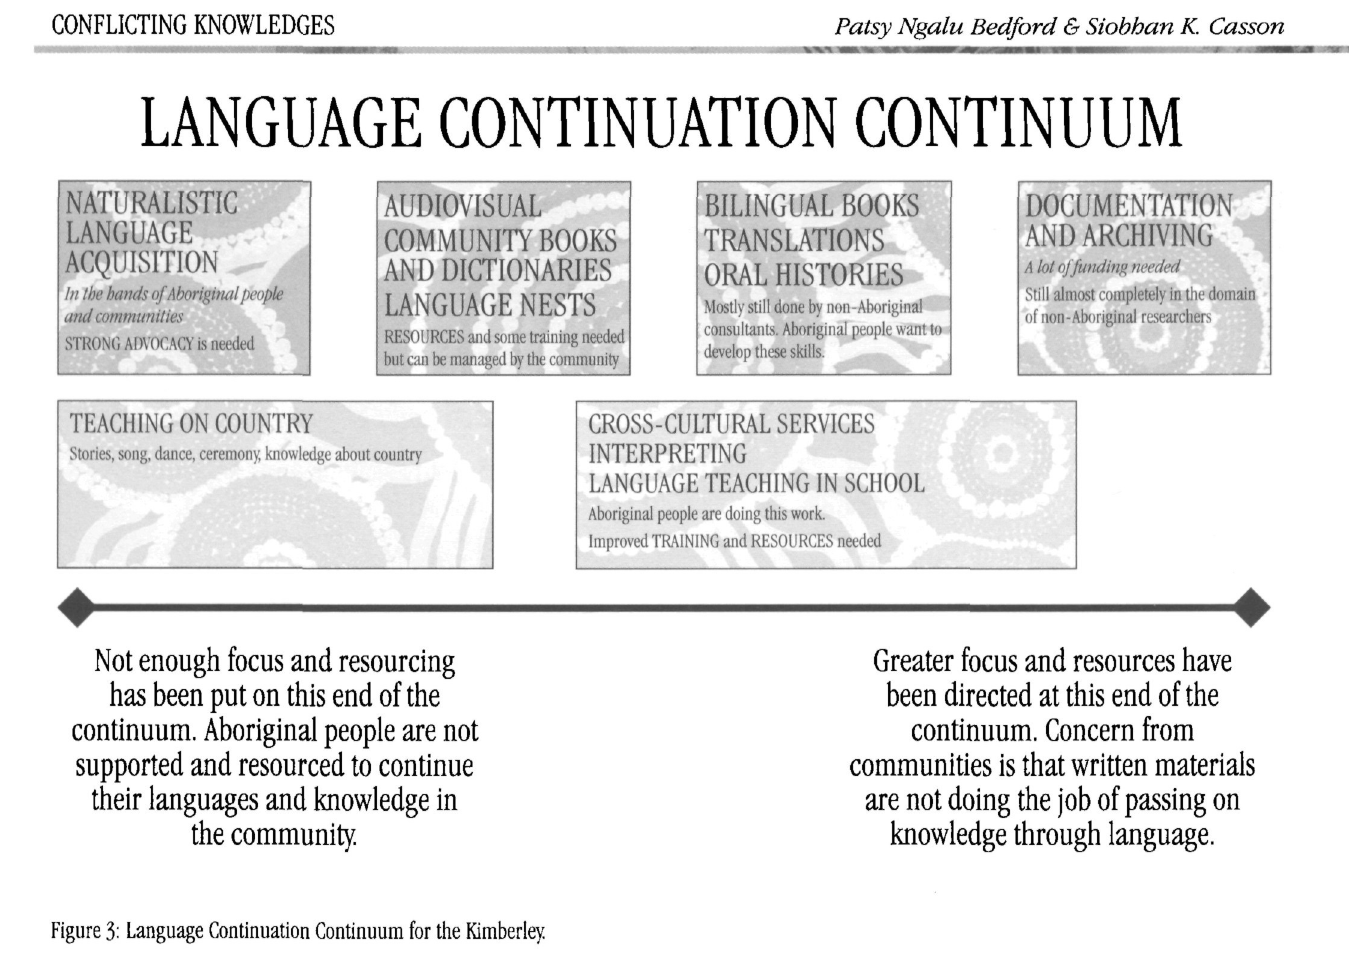
Figure 3: Language Continuation Continuum for the